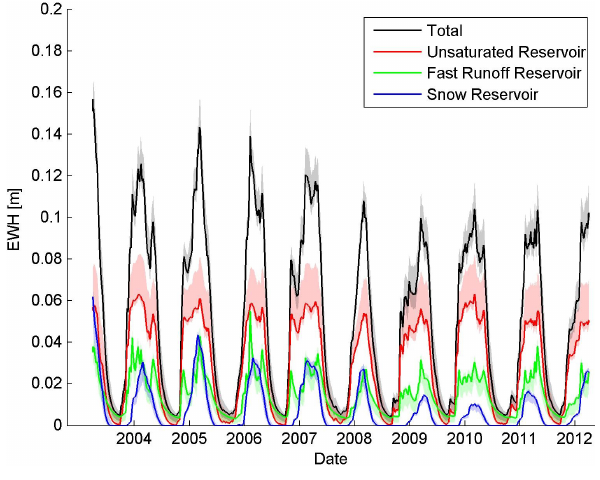
Figure 12. Comparison between resulting mass variation from GRACE and mass variation from lakes and the rainfall–runoff